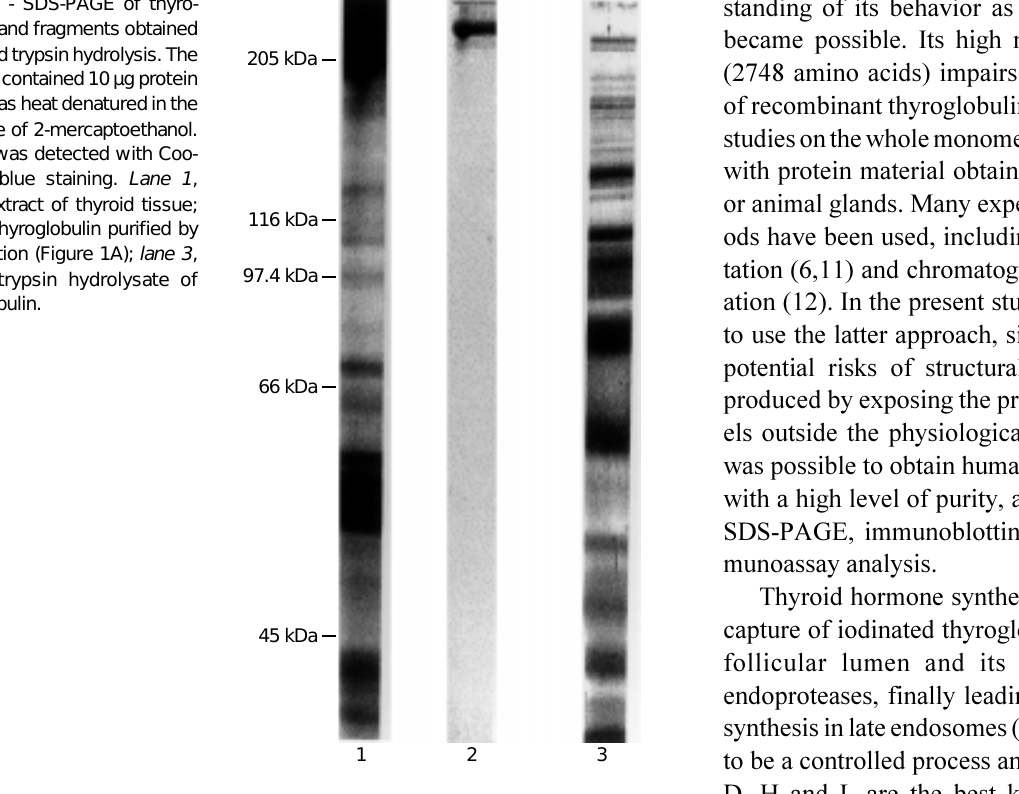
Figure 2 - SDS-PAGE of thyro- globulin and fragments obtained by limited trypsin hydrolysis. The samples contained 10 µg protein which was heat denatured in the presence of 2-mercaptoethanol. Protein was detected with Coo- massie blue staining. Lane 1 , Crude extract of thyroid tissue; lane 2 , thyroglobulin purified by gel filtration (Figure 1A); lane 3 , limited trypsin hydrolysate of